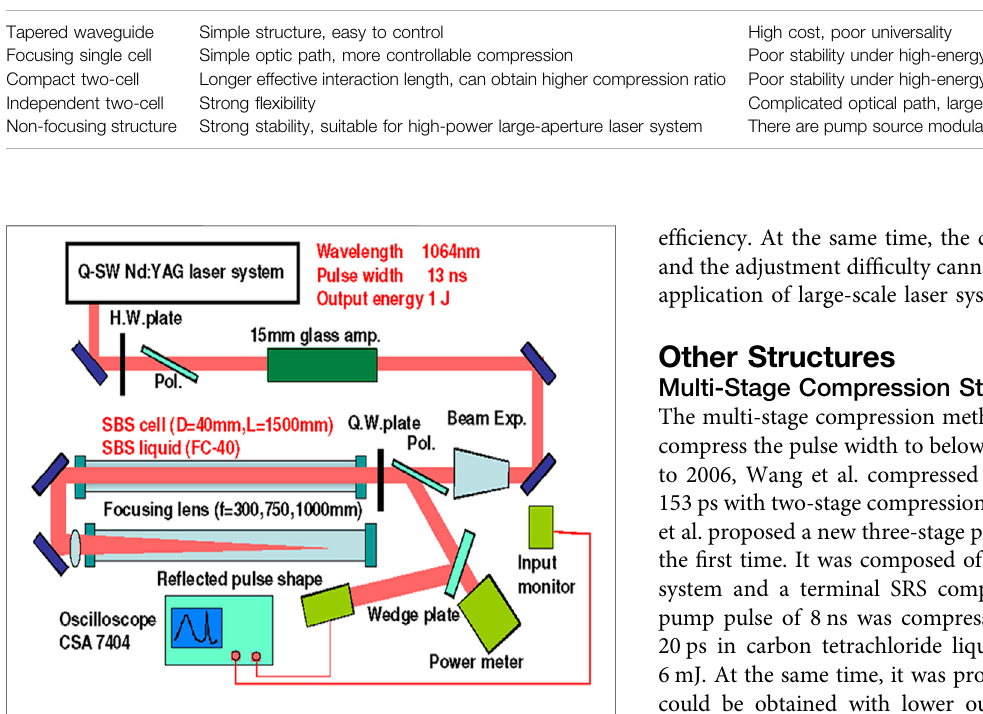
Frontiers in Physics |